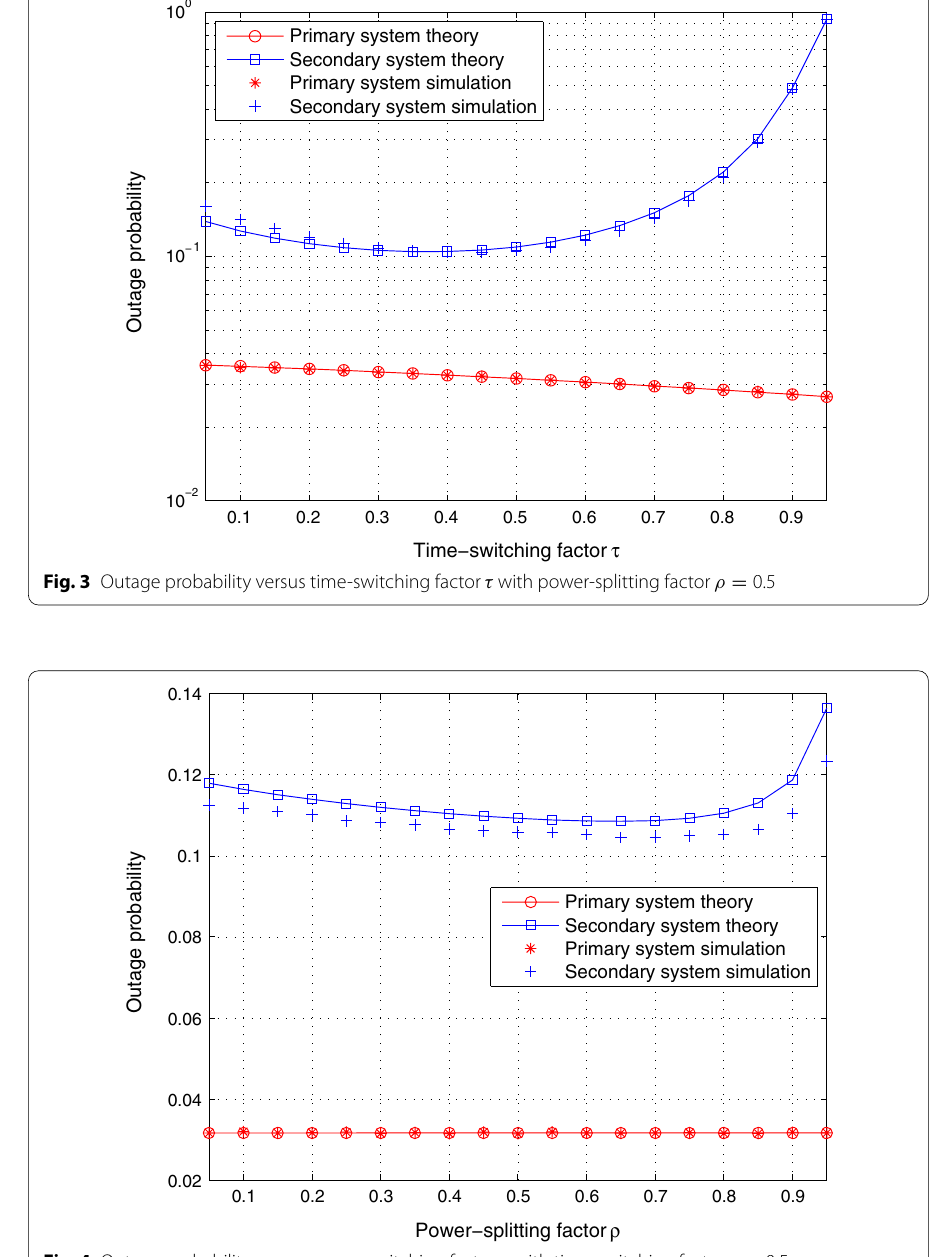
Fig. 4 Outage probability versus power-switching factor ρ with time-switching factor τ =